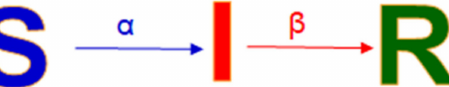
Moreover, N is normalized. So, we set N = 1; therefore, the S , I and R stand as a fraction of the